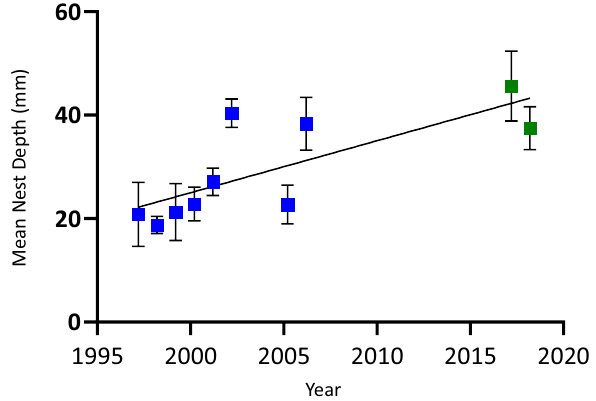
Figure 5. Long-term variation of mean nest depth of Bassiana duperreyi . The data from 1997–1998 through 2006– 2007 and 2005–2006 seasons nest depth data (blue) (Telemeco et al. 30 ) and current study (green) (2017/18 and 2018/2019).